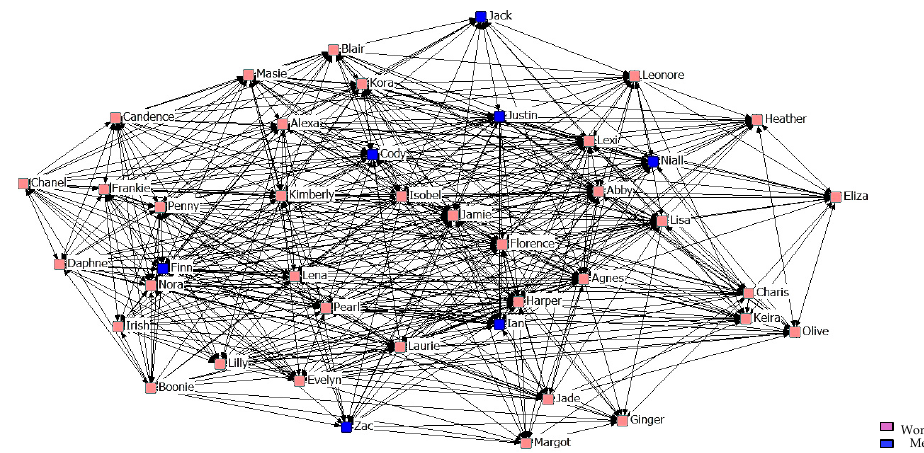
Figure 10. Graph of the third year Minimum Friendship Network.